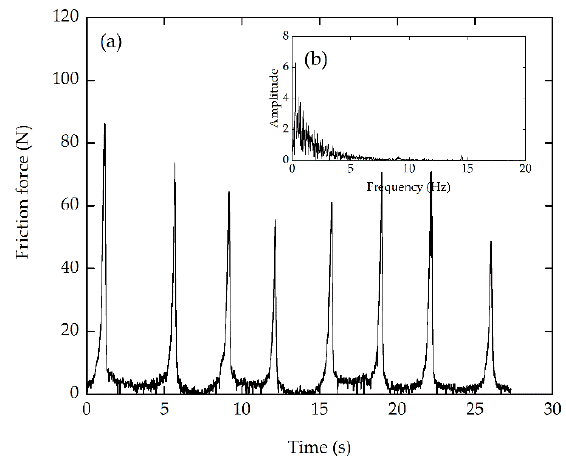
Figure 6. ( a ) U-shape friction regime on Top-Lateral// at a velocity of 0.04 m·s −1 and a normal stress of 4.56 kPa; ( b ) Fourier analysis showing that the frequency of load oscillations was 0.28 Hz in ( a ).